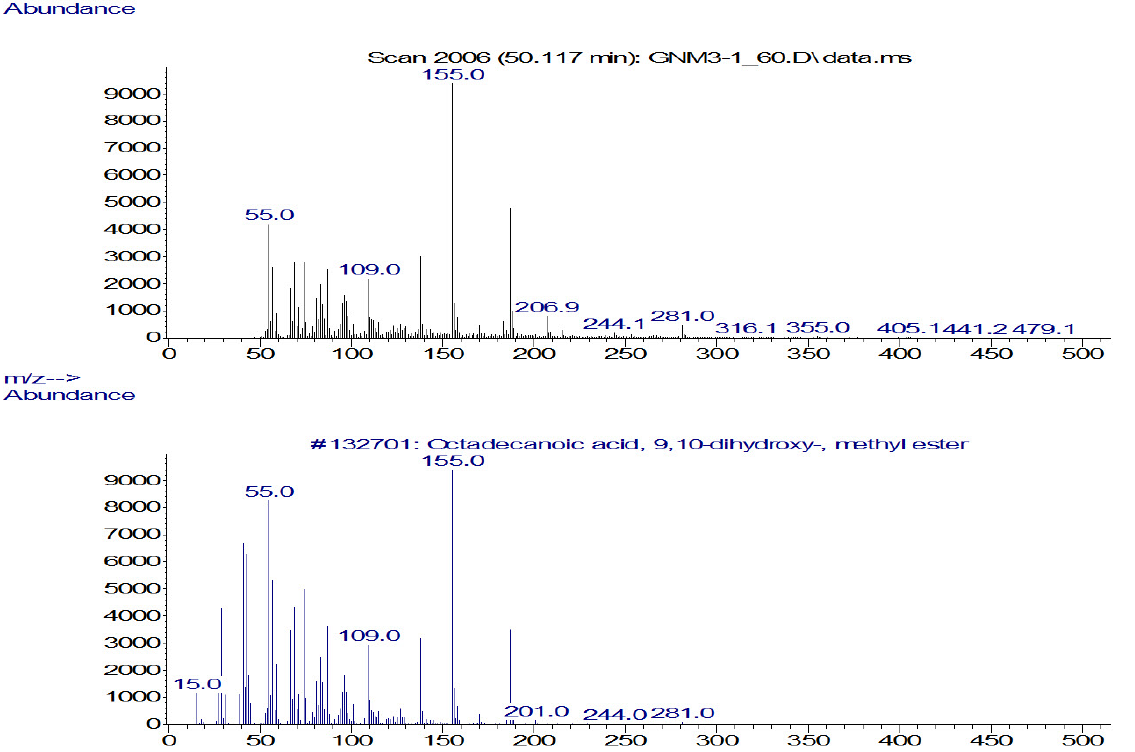
Figure 11. Mass spectra for the grinding surface core (GNM 3-1) peak at 50.117 RT (upper image) and 9, 10- dihydroxy-octadecanoic acid, methyl ester from the NIST mass spectral database 2.1(lower